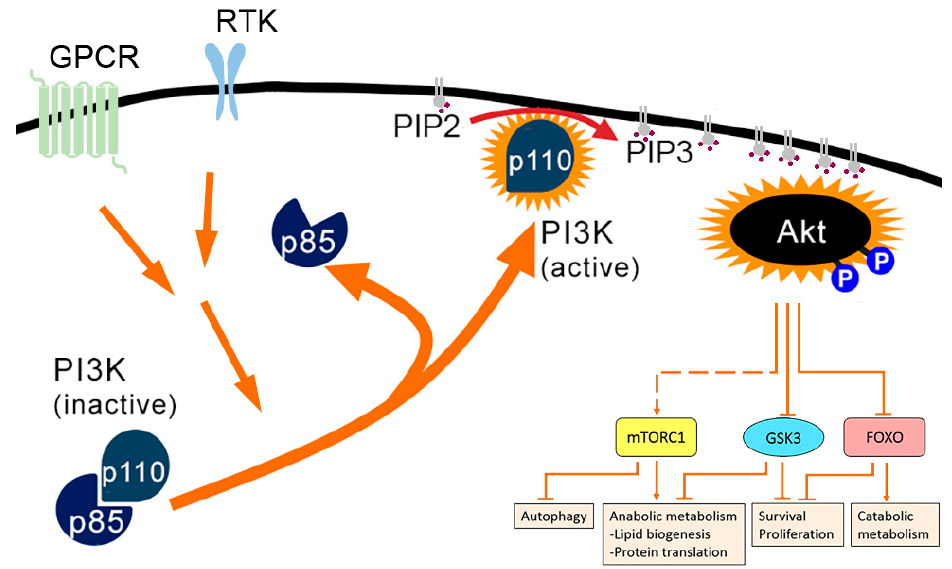
Figure 1. Activation of PI3K-AKT pathway by external signals via G-protein coupled receptors (GPCR) or receptor tyrosine kinases (RTK) leads to dissociation of the p85 regulatory subunit from the active p110 PI3K subunit. The active subunit catalyses the conversion of PIP2 to PIP3 at the plasma membrane, leading to the recruitment and activation of the AKT kinase. Via multiple downstream effector pathways, cellular states of growth, proliferation, heightened metabolic activity and survival are promoted. For more details, see text.